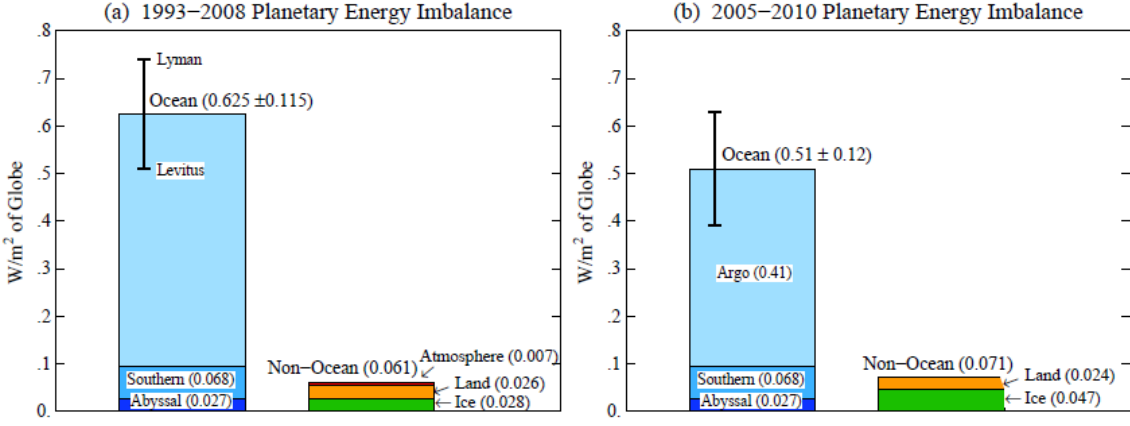
Fig. 10. (a) Estimated contributions to planetary energy imbalance in 1993–2008, and (b) in 2005–2010. Except for heat gain in the abyssal ocean and Southern Ocean, ocean heat change beneath the upper ocean (top 700m for period 1993–2008, top 2000 m in period 2005–2010) is assumed to be small and is not included. Data sources are the same as for Figs. 8 and 9. Vertical whisker in (a) is not an error bar, but rather shows the range between the Lyman et al. (2010) and Levitus et al. (2009) estimates. Error bar in (b) combines estimated errors of von Schuckmann and Le Traon (2011) and Purkey and Johnson (2010).